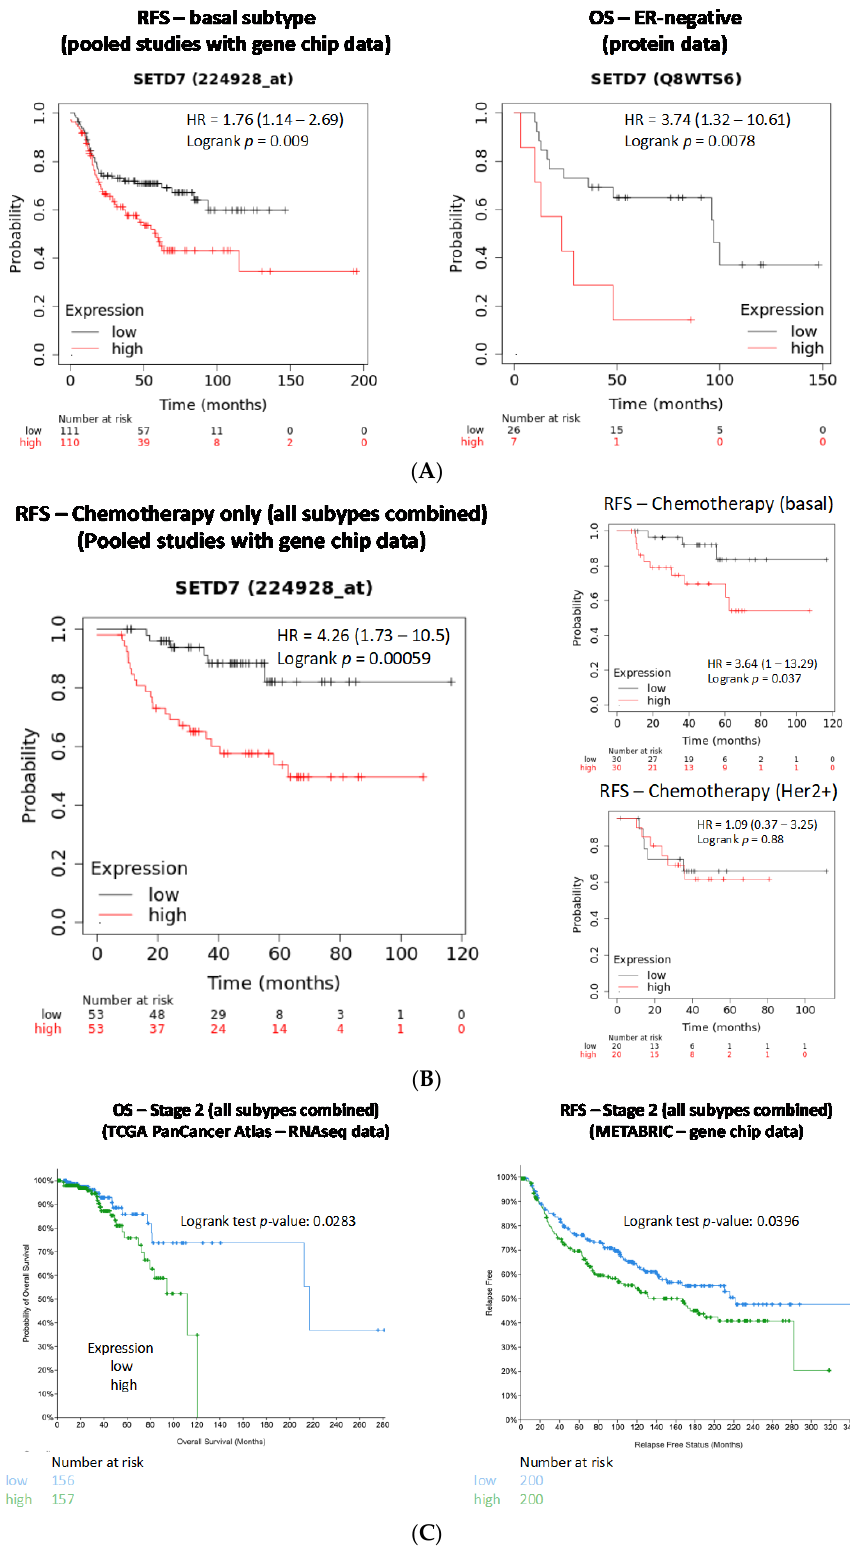
Figure 6. Analysis of the effect of differential SETD7 expression on survival outcomes of BC patients. ( A ) Influence of SETD7 mRNA or protein expression levels on survival outcomes for patients